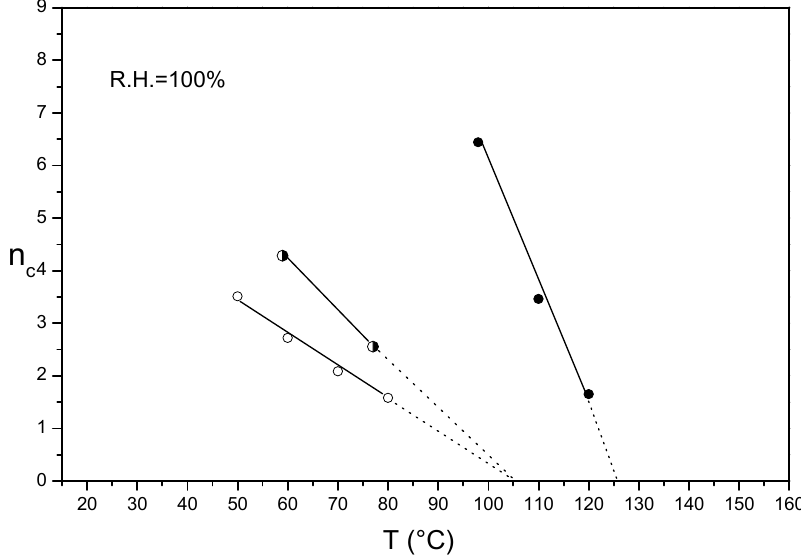
Figure 5. n c / T plot of un-crystallized Aquivion ® 830: as cast ( empty circles ), after treatment at 135 ◦ C for 15 h ( half empty circles ) and treated at 135 ◦ C for 15h and annealed at 135 ◦ C in presence of DMSO for 7 days ( full circles ).